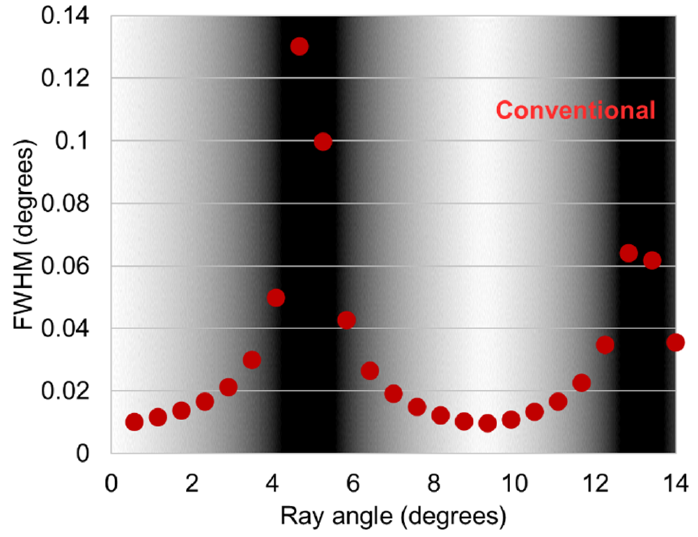
Figure 4. Calculation results of ray-angle dependence of display resolution (red circle dots) and luminance distribution according to each ray angle (background shading) with conventional one- sided image input.